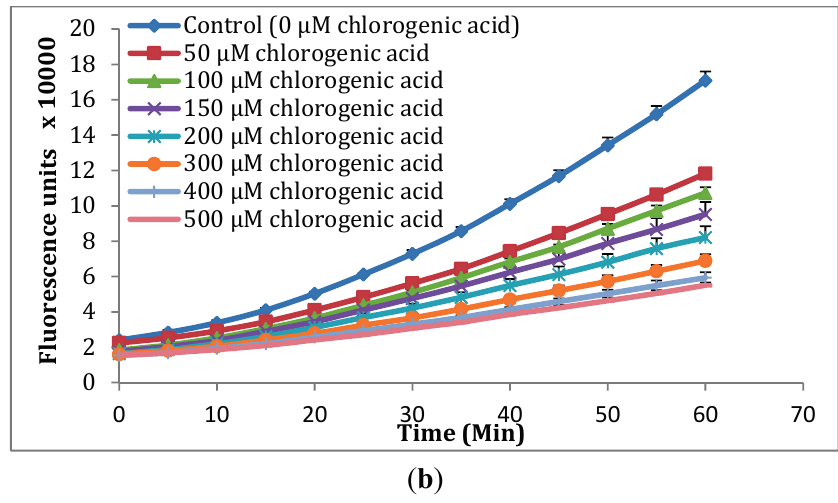
Figure 2. Peroxyl radical-induced oxidation of DCFH to DCF in WI-38 cells and inhibition of oxidation by ( a ) S. oleraceus leaf extracts and ( b ) chlorogenic acid with time. The fluorescence intensity indicates the oxidation of DCFH. The curves shown in each graph are from a single experiment (mean + SD, n = 3).